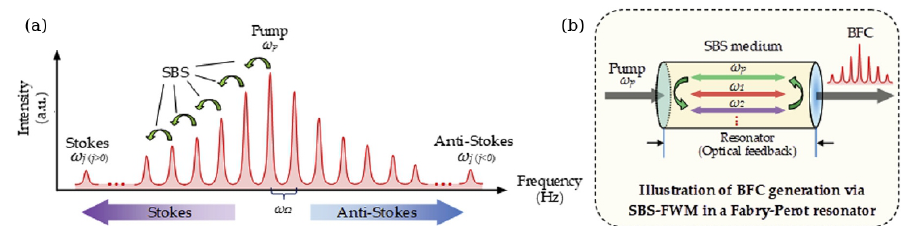
Figure 7. Illustration of the generation of an SBS-based FC. ( a ) The spectrum of an SBS FC showing the Stokes and anti-Stokes frequency peaks generated due to the SBS effect. ( b ) Illustration of a cascaded SBS effect combined with FWM arising from the optical Kerr-nonlinearity. Reproduced from [17] with permission of